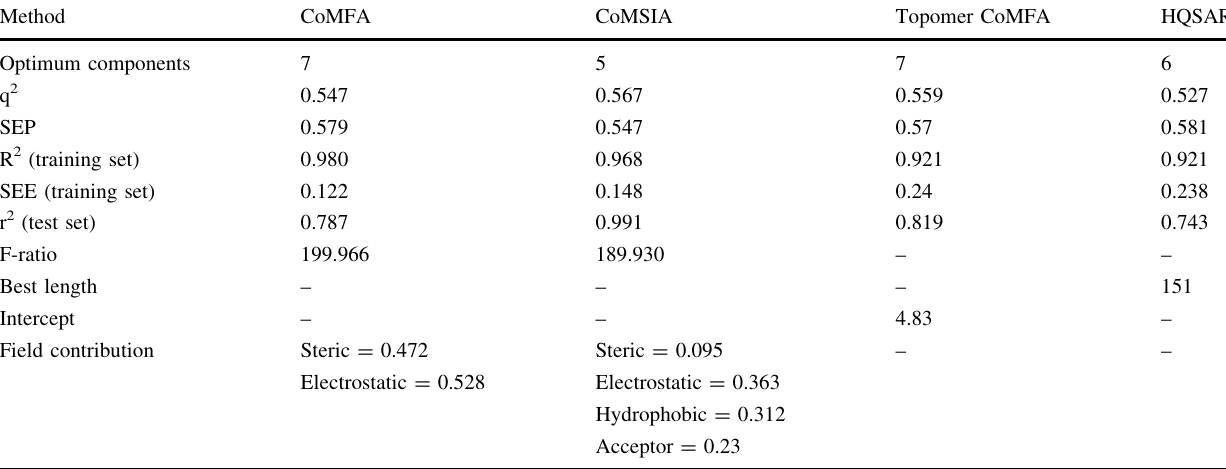
Table 2 Summary of the statistical results of CoMFA, CoMSIA, topomerCoMFA and HQSAQ models